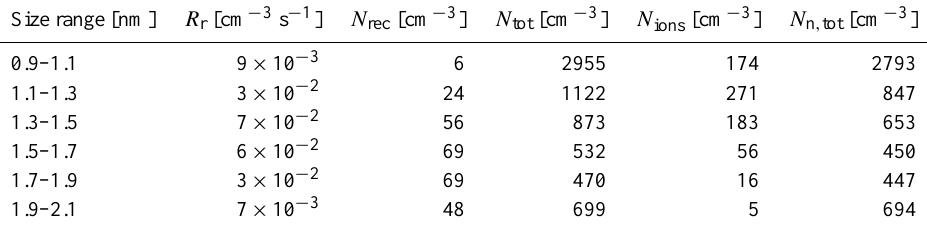
Table 4. The median values for the recombination production rate ( R r ) and the concentrations of recombination products ( N rec ) , all clusters ( N tot ) , charged clusters ( N ions ) and all neutral clusters ( N n , tot ) in six size classes between 0.9 and